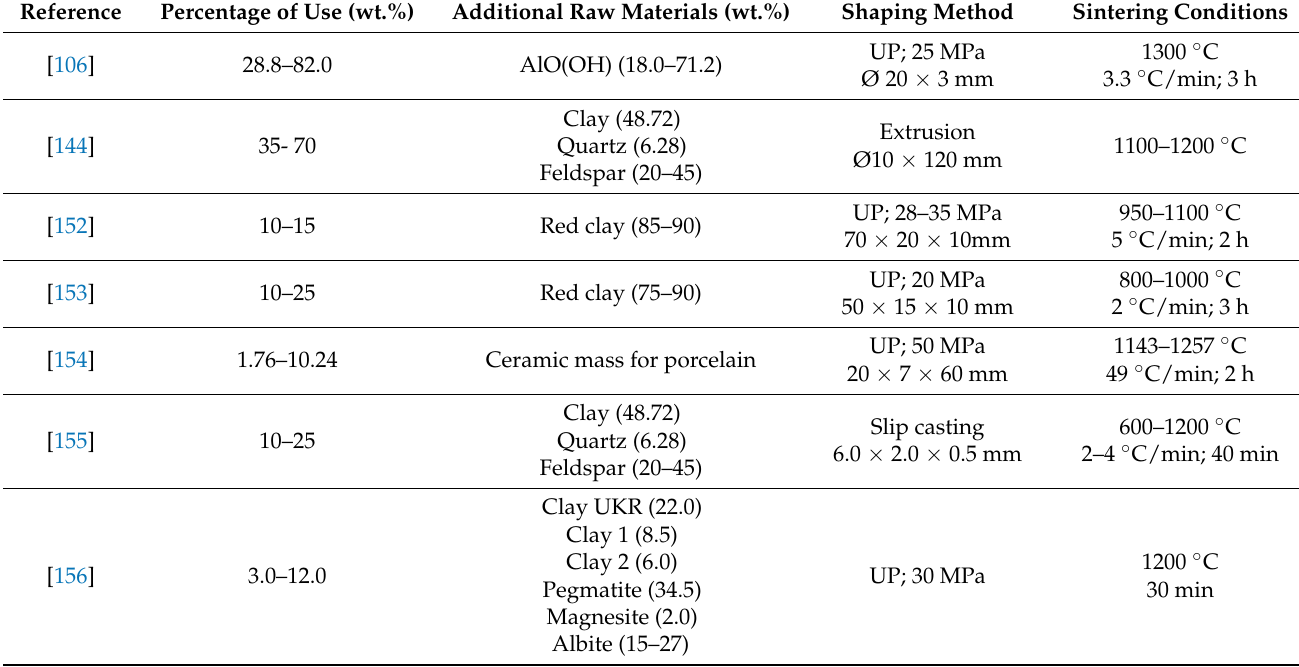
Table 24. Experimental conditions used in the development of mullite-based materials from quartz and quartzite waste. Reference